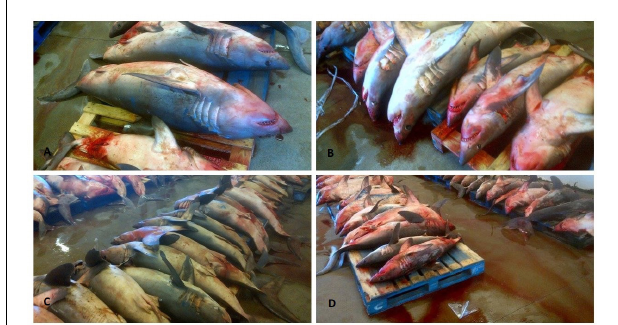
FIGURE 1 | The 53 porbeagle sharks, captured as seasonal by-catch in gillnet fisheries. Individual specimens were frozen and transferred to Cefas (Lowestoft) for research. All porbeagle sharks were sexed, measured and weighed (A–D) . After examination, the sharks were dissected and spiral valve removed for microplastic analysis.